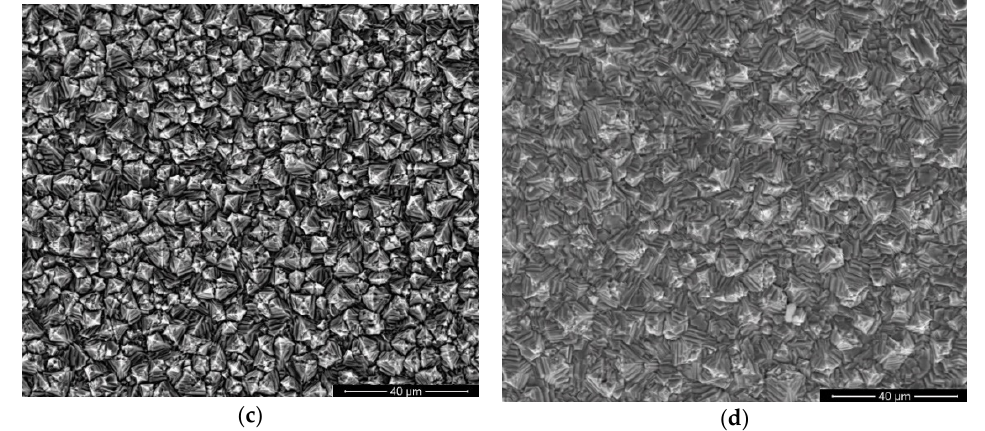
Figure 1. SEM Scanning electron microscopy of surface morphology of epoxy resin/zinc hybrid coatings electrodeposited at different parameters: ( a ) sample A; ( b ) sample B; ( c ) sample C; ( d ) sample D. Magnification: 2000×.